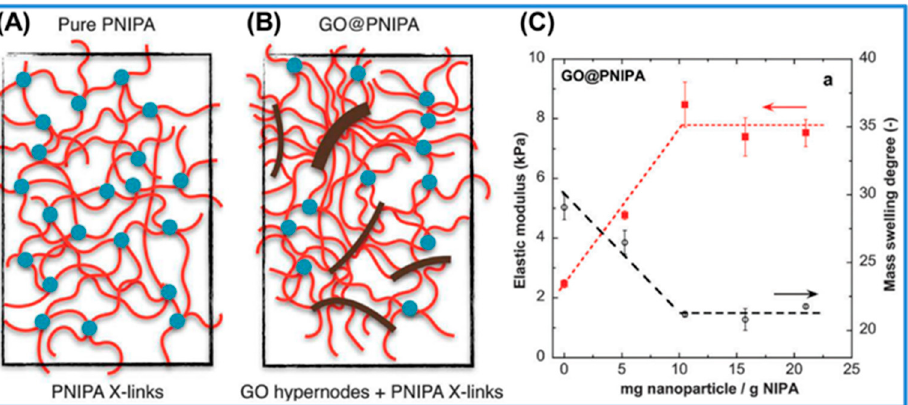
Figure 1. Schematic representation of the structures of ( A ) pure PNIPAM and ( B ) GO / PNIPAM composite gels. ( C ) Equilibrium mass swelling degree in pure water at 20 °C and the elastic modulus of GO / PNIPAM composite gels. Adapted with permission from Ref. [72]. Copyright (2016) The Royal Society of Chemistry. Note that in the source article, PNIPAM is referred to as PNIPA.